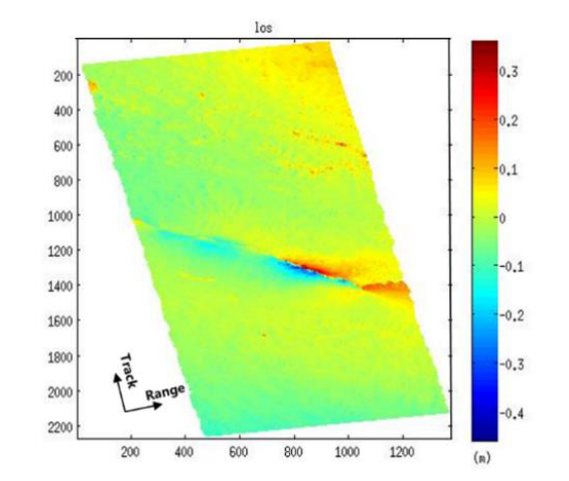
Figure 4. Corrected MAI interferogram